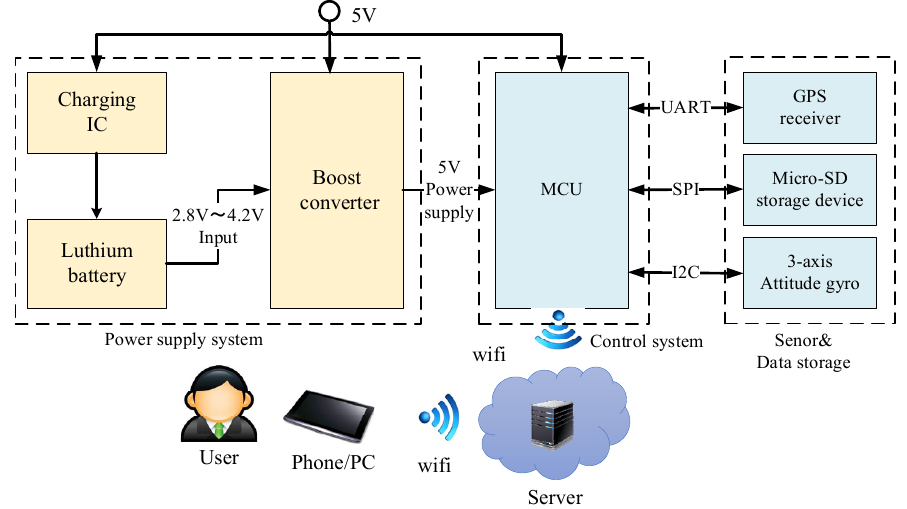
Figure 2. Development Architecture of the STB Monitoring Device.